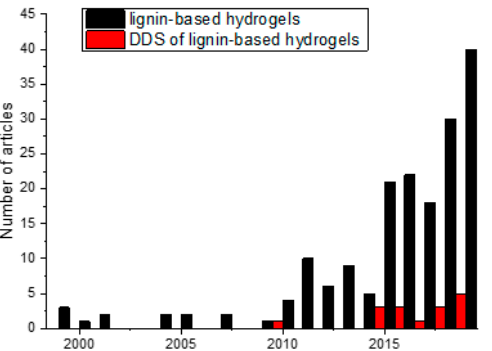
Figure 12. Progress of publications in (black) lignin-based hydrogels and (red) drug delivery systems based on lignin hydrogels, data obtained from